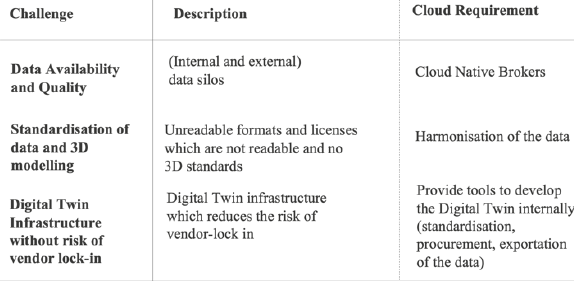
Figure 4 . Urban Digital Twin cloud requirements.